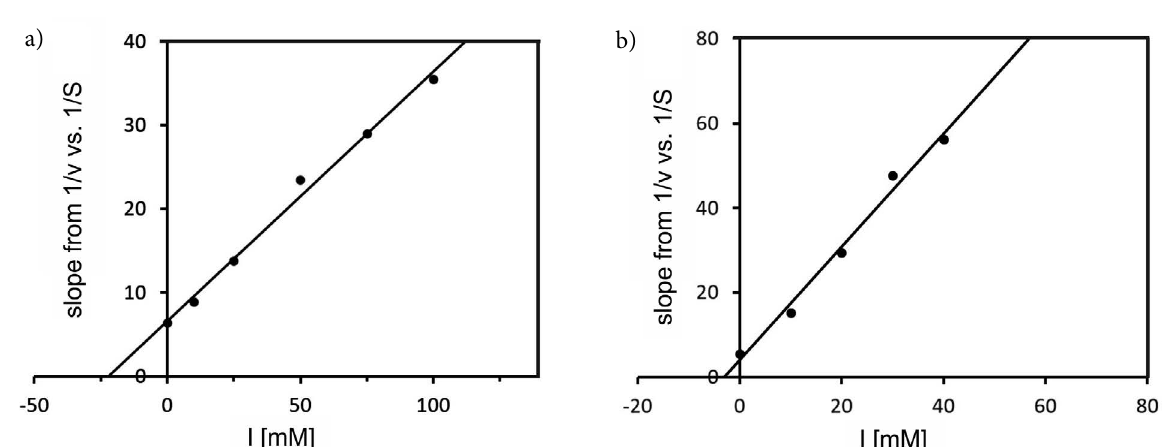
Figure 4. Proteolytic inhibition of cathepsin C by dipeptides Glu-Lys and Gly-Glu. K i values for inhibition of cathepsin C by dipeptides (a) Glu-Lys (20 mM) and (b) Gly-Glu (2.5 mM) were determined by secondary plots.